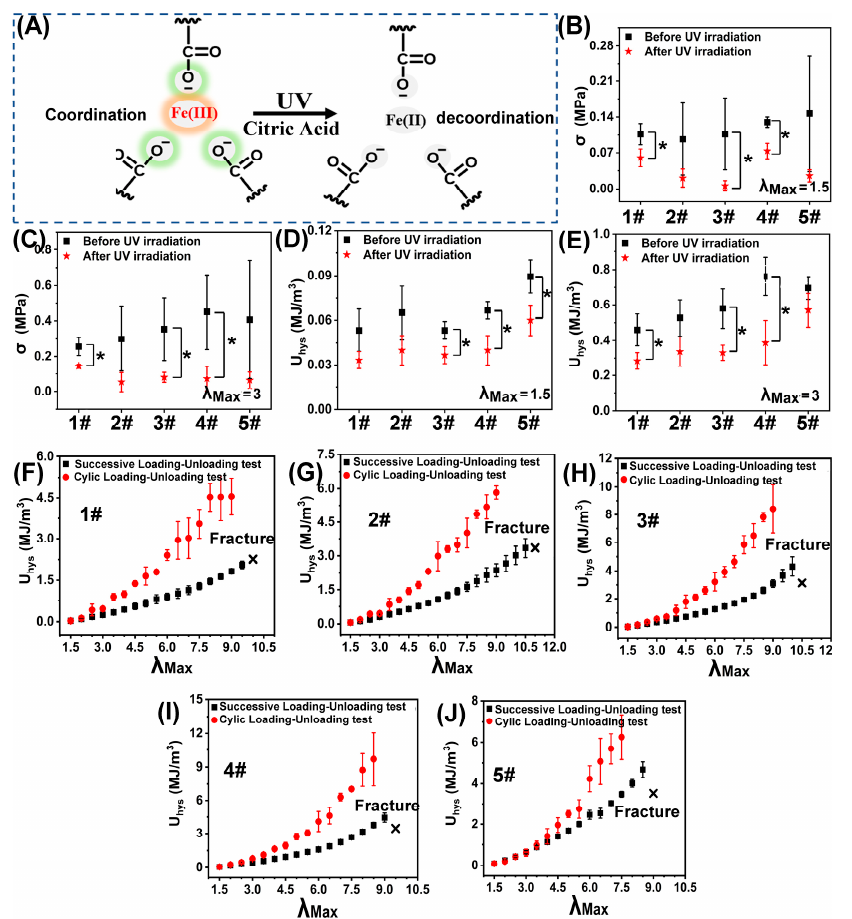
Figure 3. ( A ) Schematic diagram showing the decoordination of Fe(III)-COOO − under UV radiation; Tensile stress and dissipation energy of sample 1#, 2#, 3#, 4#, and 5 # under low tension of λ max = 1.5 ( B , D ) and λ max = 3 ( C , E ) before and after UV radiation (* p < 0.05); Dissipation energy of sample 1# ( F ), 2# ( G ), 3# ( H ), 4# ( I ), and 5 # ( J ) subjected to cyclic loading–unloading test and successive loading–unloading test.